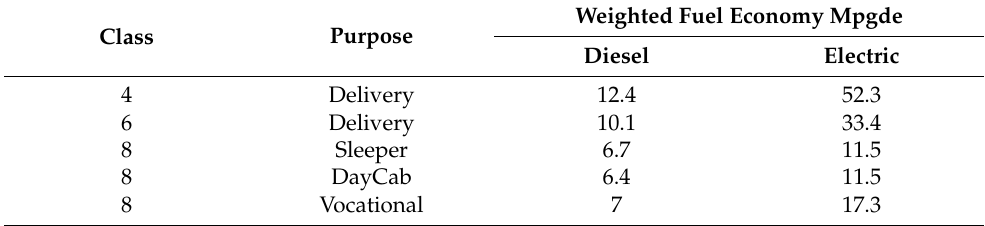
Table 5. Diesel equivalent fuel economy.